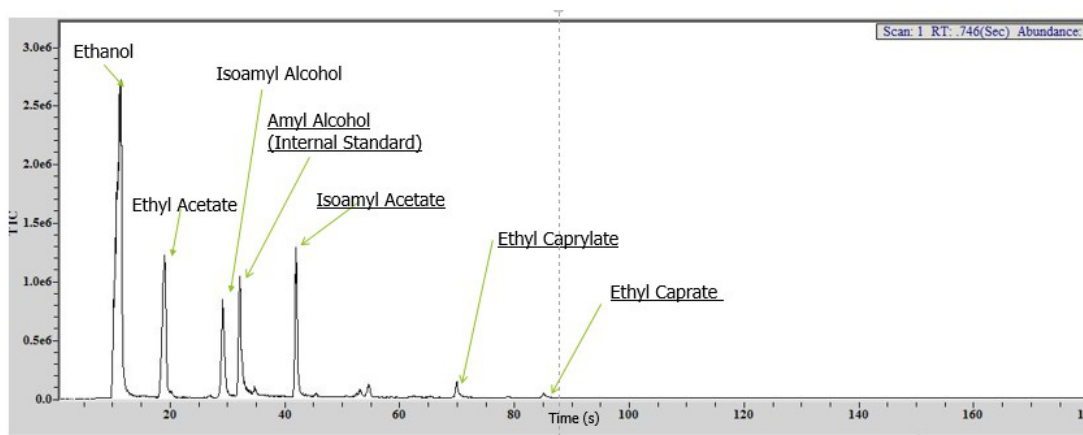
Figure 2. Headspace SPME chromatogram of an IPA style beer (sample 2).